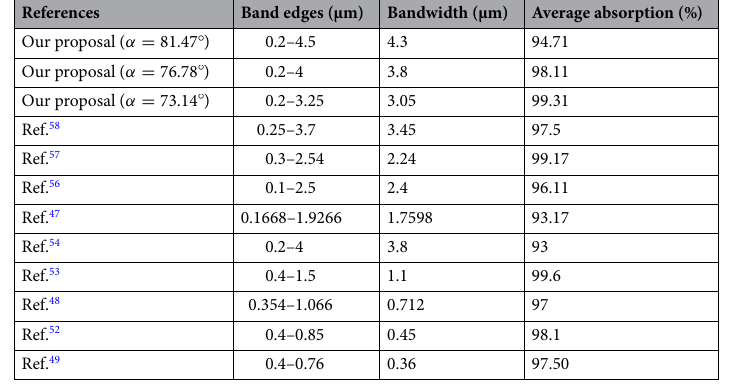
Table 2. Comparison of our proposed superabsorber with recently-reported relevant